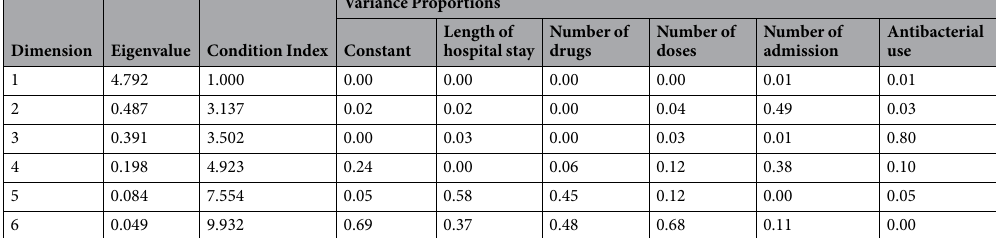
Table 5. Collinearity diagnostics results of the factors associated with the occurrence of